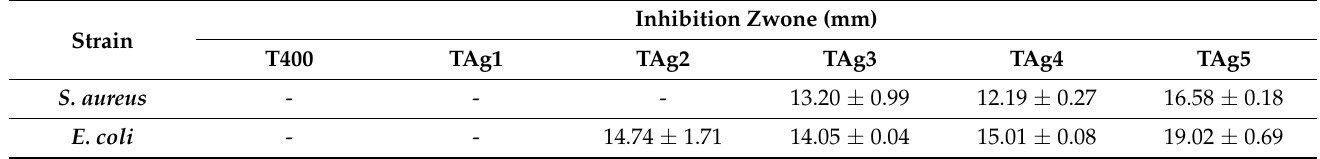
Table 5. Antimicrobial activity of the tested compounds against the reference strains.